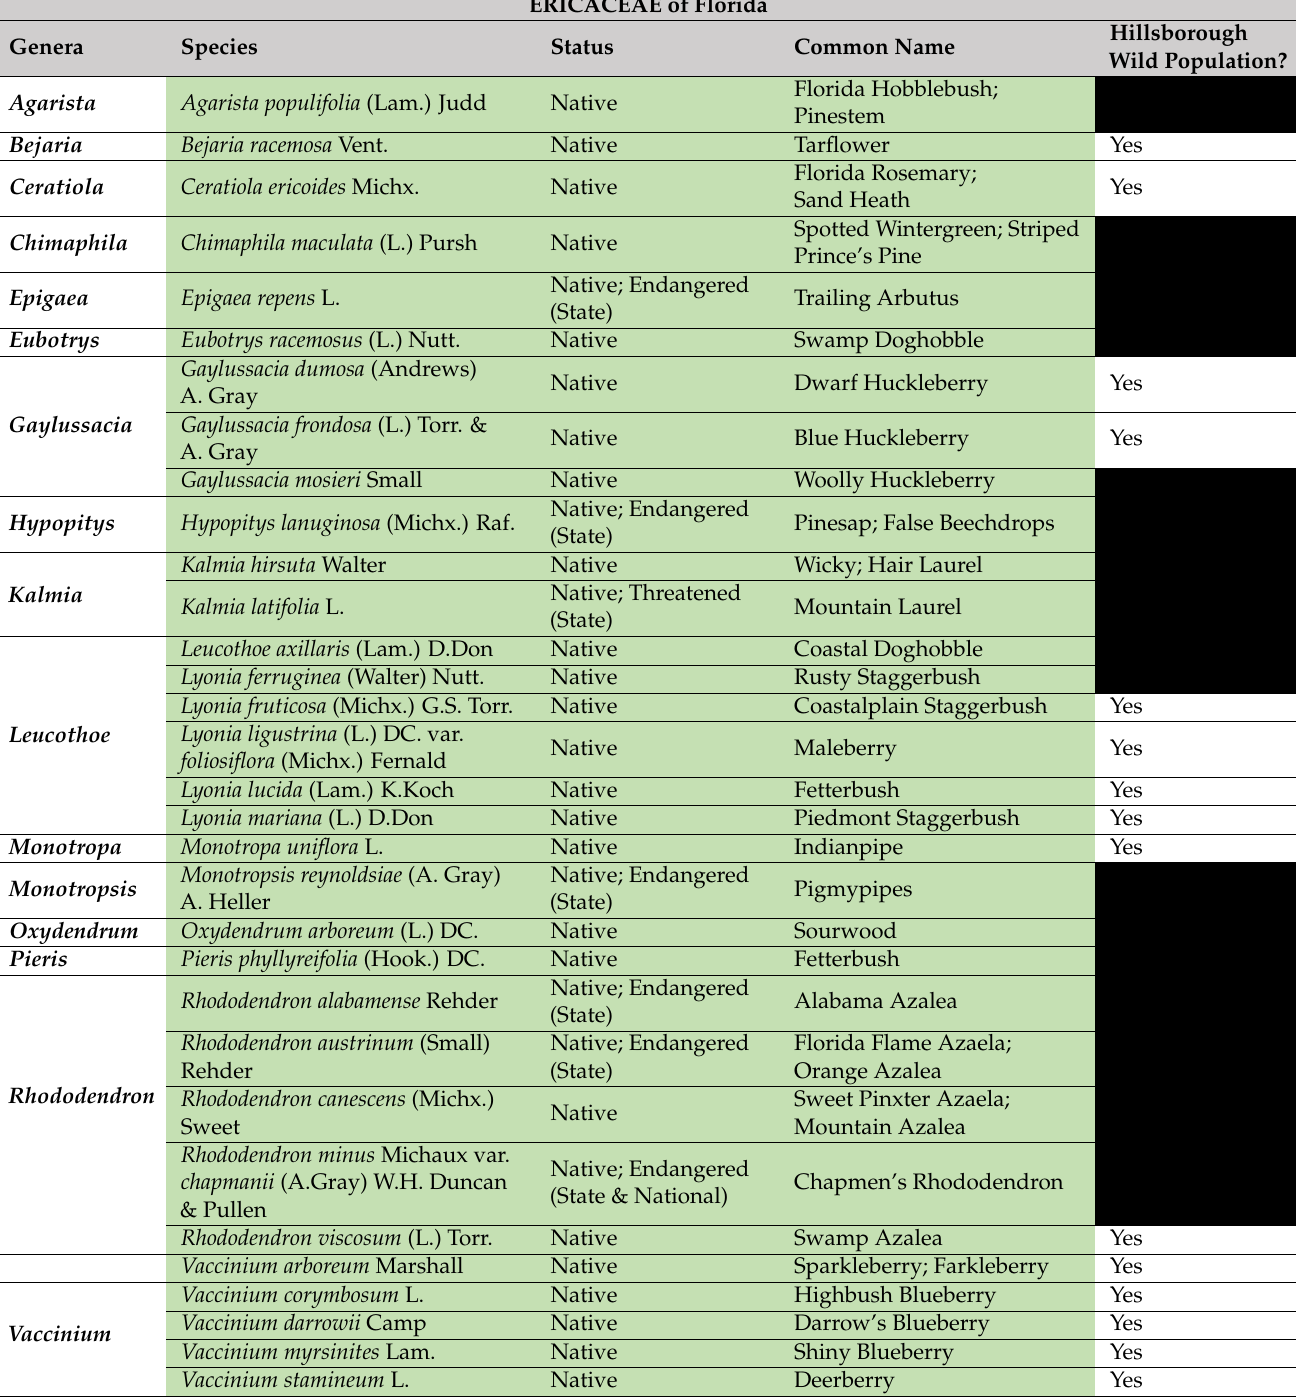
Table 2. Ericaceae Family Plant Genera in Hillsborough County, Florida, United